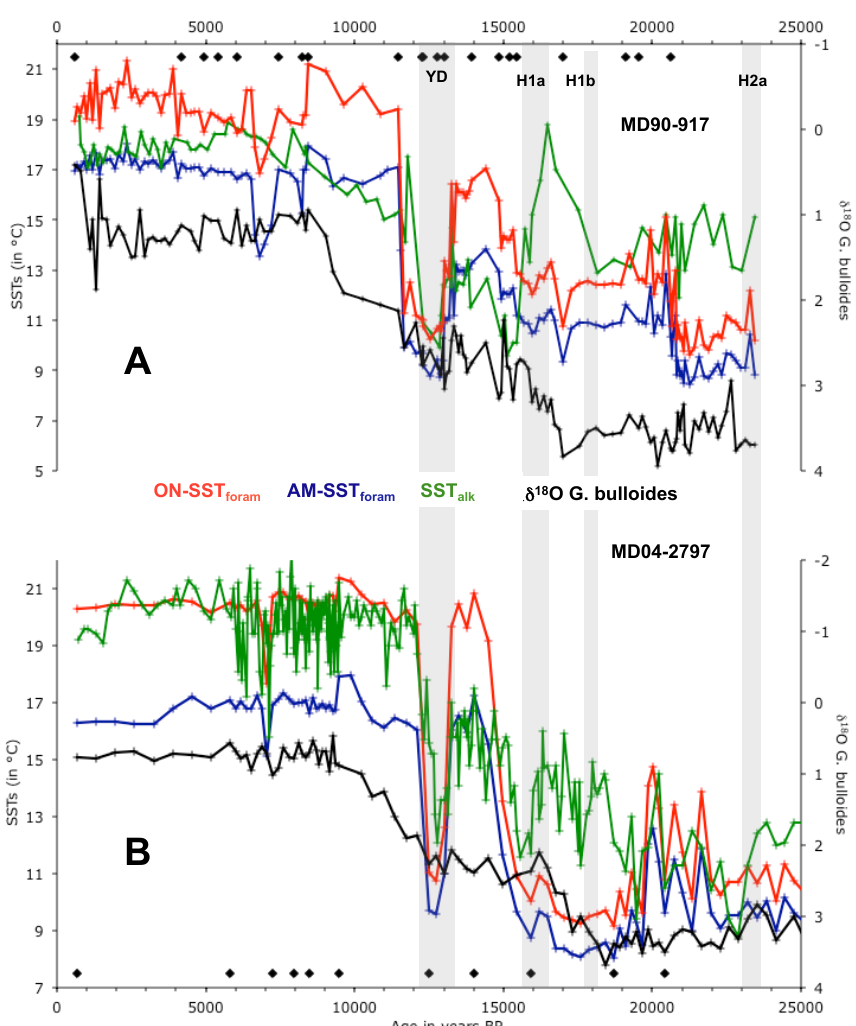
Fig. 2. SSTs derived from planktonic foraminifera assemblages for April–May (AM-SST foram ) and October–November ON-SST foram and alkenones (SST alk ) and the δ 18 O determined in G. bulloides calcite (in ‰). (A) The upper panel shows the South Adriatic Sea core MD90-917 (41 ◦ N, 17 ◦ E; − 1010.0m) data – δ 18 O determined in G. bulloides calcite (in ‰) (Siani et al., 2004, 2010) – Sea surface temperatures (in ◦ C) derived from planktonic foraminifera assemblages for April–May and October–November (AM-SST foram and ON-SST foram , respectively) (Siani et al., 2004, 2010) – Sea surface temperature derived from SST alk (in ◦ C) (this study). (B) The lower panel shows the Siculo–Tunisian Strait core MD04-2797 (36 ◦ N, 11 ◦ E; − 771m) data. – δ 18 O determined in G. bulloides calcite (in ‰) (Essallami et al., 2007) – sea surface temperatures (in ◦ C) derived from planktonic foraminifera assemblages for April–May and October–November (AM-SST foram and ON- SST foram , respectively) (Essallami et al., 2007) – sea surface temperature derived from alkenones SST alk (in ◦ C) (Essallami et al., 2007 and this study). Shaded areas in grey indicate the Younger Dryas (YD), the Heinrich stadial time intervals H1a (16kyr), H1b (17.5kyr) and H2a (23.5kyr) according to Bard et al.